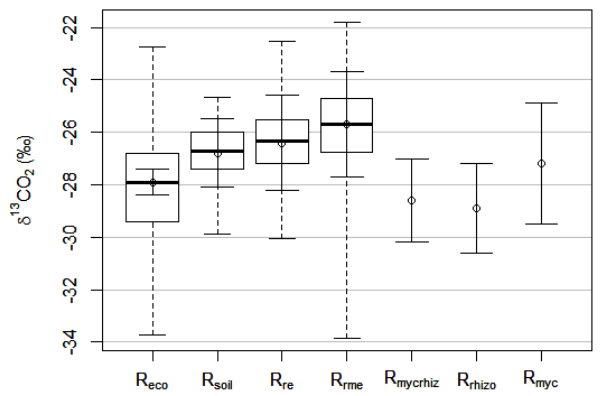
Figure 3. Relative contributions made by rhizospheric, mycorrhizal fungi and heterotrophic components to the total soil respiration in the different parts of the vegetation period (15 May 2013–12 November 2013) at Bugac site. Propagated uncertainties of each estimate are shown in the lower panel. Gray horizontal lines show y major